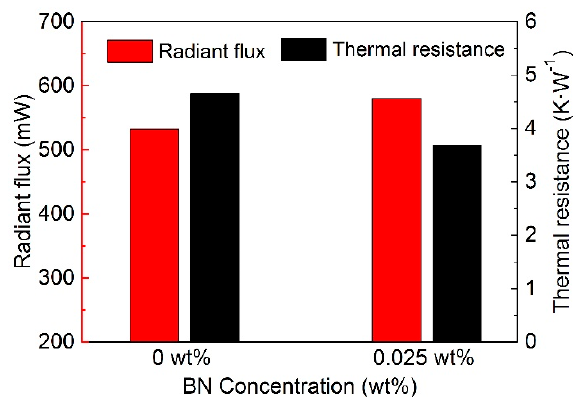
Figure 8. Comparison of radiant flux and thermal resistance between UVLED with 0 wt% and 0.025 wt% BN NPs groups under 400 mA. Radiant flux is indicated by red bars, thermal resistance by black bars.